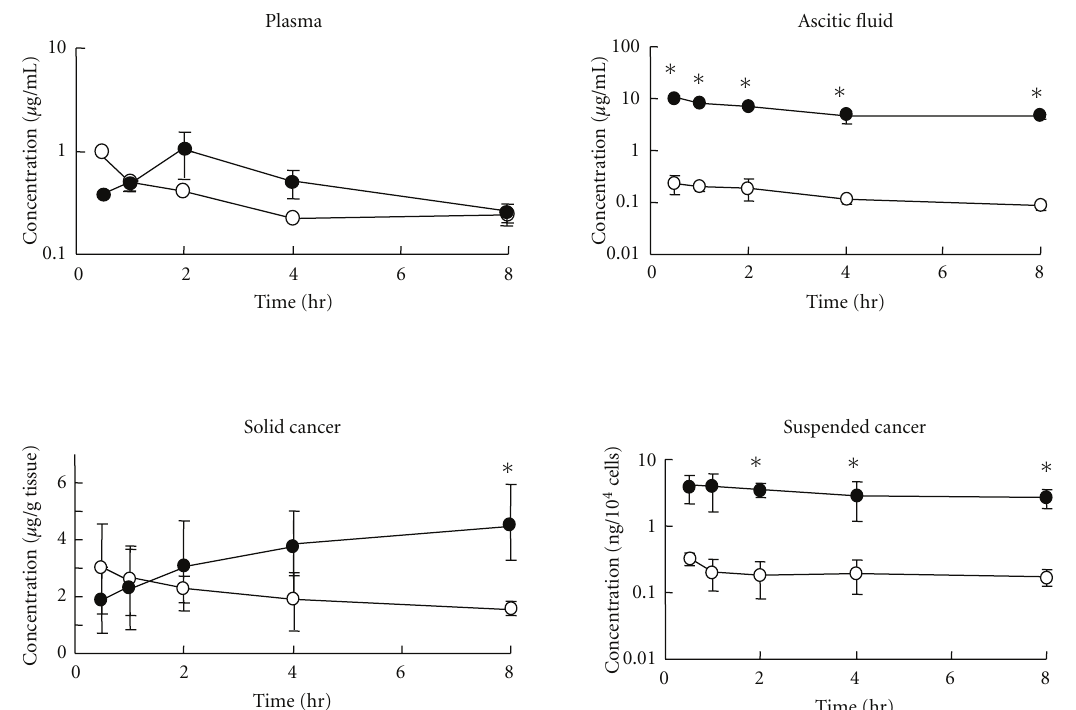
Figure 6: Time courses of docetaxel concentration in plasma, ascetic fluid, solid cancer, and suspended free cancer cells after an i.v. or i.p. injection of Taxotere in MKN-45P gastric cancer-bearing mice [17]. Taxotere (8mg/kg) was i.v. (open symbols) or i.p. (closed symbols) injected into cancer-bearing mice on day 21 after i.p. inoculation of 10 7 MKN-45P gastric cancer cells. Each point with bar represents the mean ± SD of three mice. ∗ Significantly di ff erent from i.v. injection at P < 0 . 05.